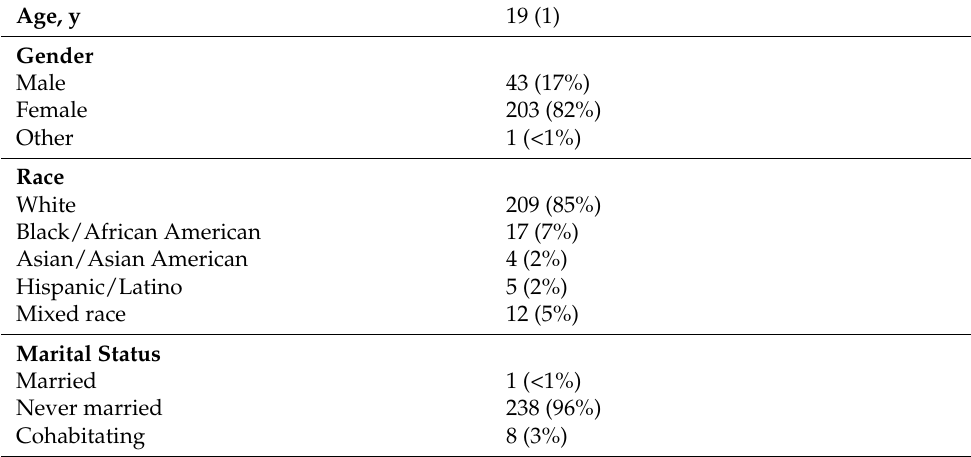
Table 1. Demographic